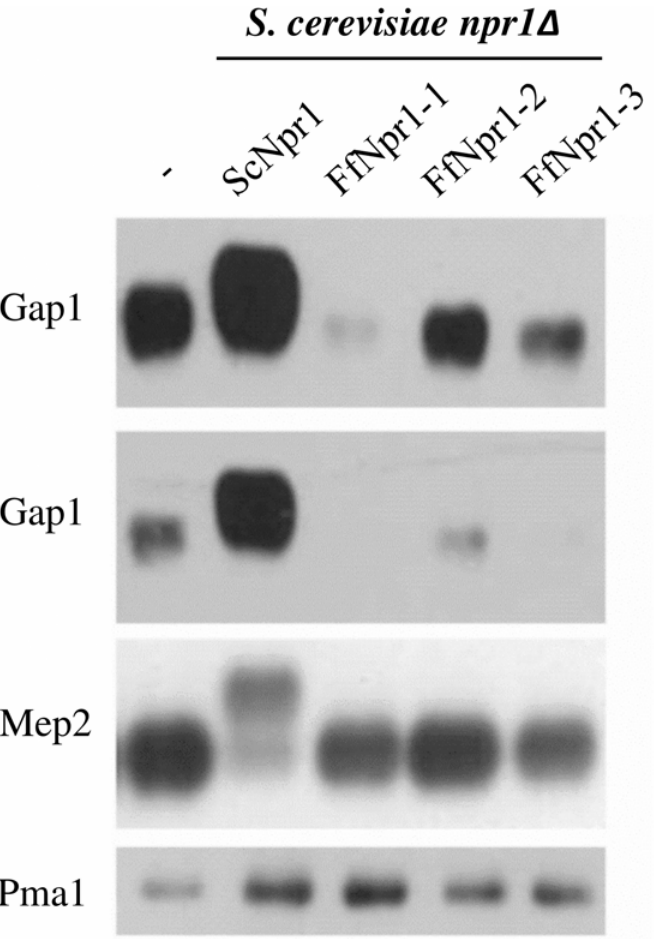
Fig 6. F . fujikuroi Npr1-like kinases do not have an impact on Gap1 stability in yeast. The S . cerevisiae npr1 Δ mutant and npr1 Δ transformed with FfNPR1-1 , FfNPR1-2 , FfNPR1-3 and ScNPR1 were cultivated in liquid minimal medium with low amounts of urea as sole nitrogen source. Membrane enriched protein extracts were used for Western blot analysis. Specific antibodies were used to detect Gap1 and the ammonium permease Mep2. Pma1 was detected as protein loading